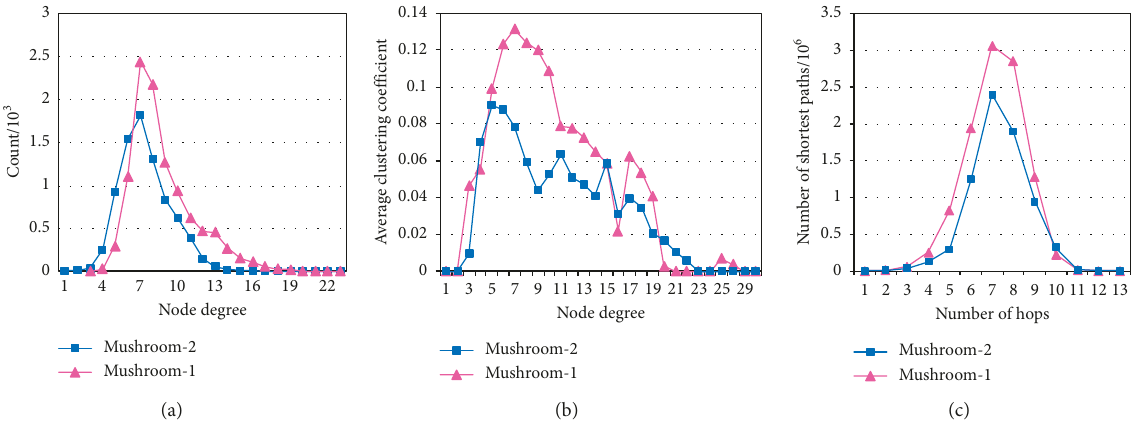
Figure 4: The structural characteristics of concept lattices on the mushroom date set. (a) Degree distribution. (b) Clustering coefficient. (c) Average path length. Table 5: The third group dataset. Lattices Node